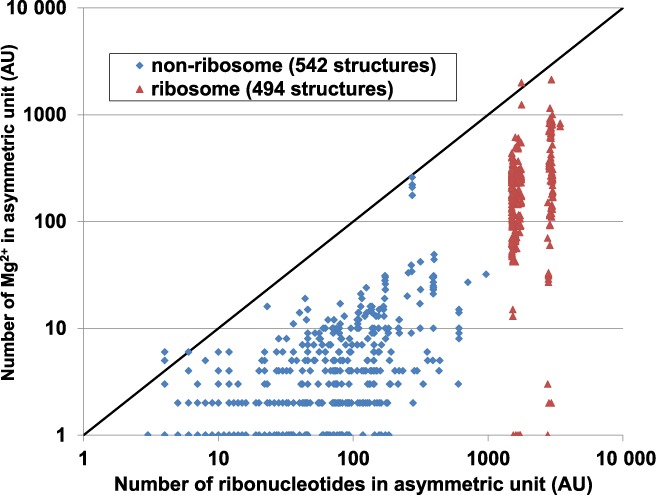
Number of Mg2+ ions versus number of ribonucleotides in the asymmetric unit (AU), as plotted separately for ribosome (red) and non-ribosome structures (blue) on a log–log plot. A line indicating an equal number of ribonucleotides and Mg2+ ions is shown. It must be noted that not all Mg2+ are modeled in X-ray crystal structures due to diffusely bound Mg2+, resolution limitations and model building strategies.